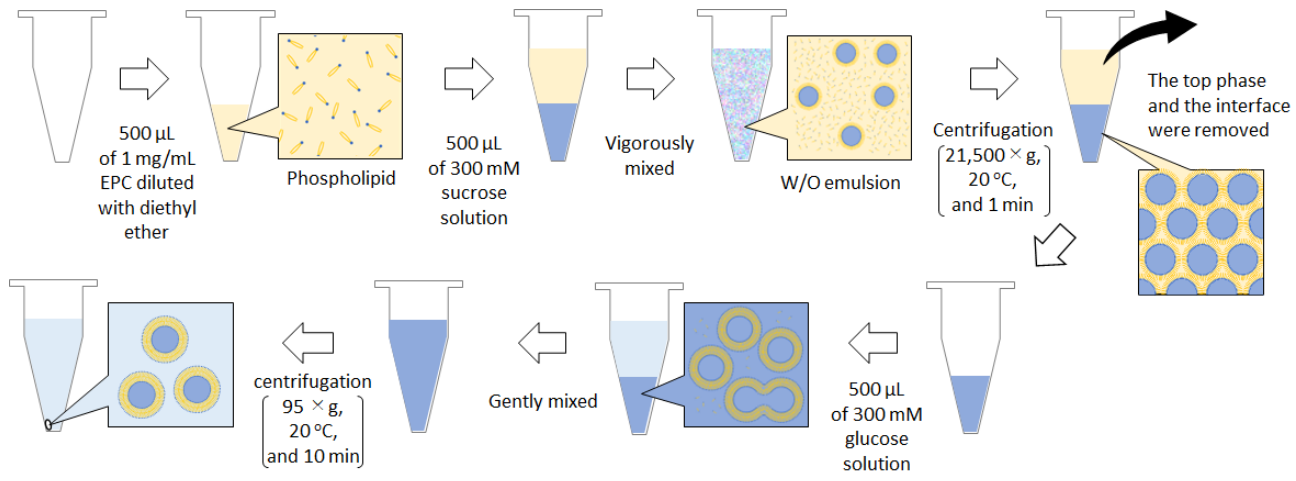
Figure 4. Schematic illustration of the protocols of the W/O emulsion template method focusing on the effective removal of oil.